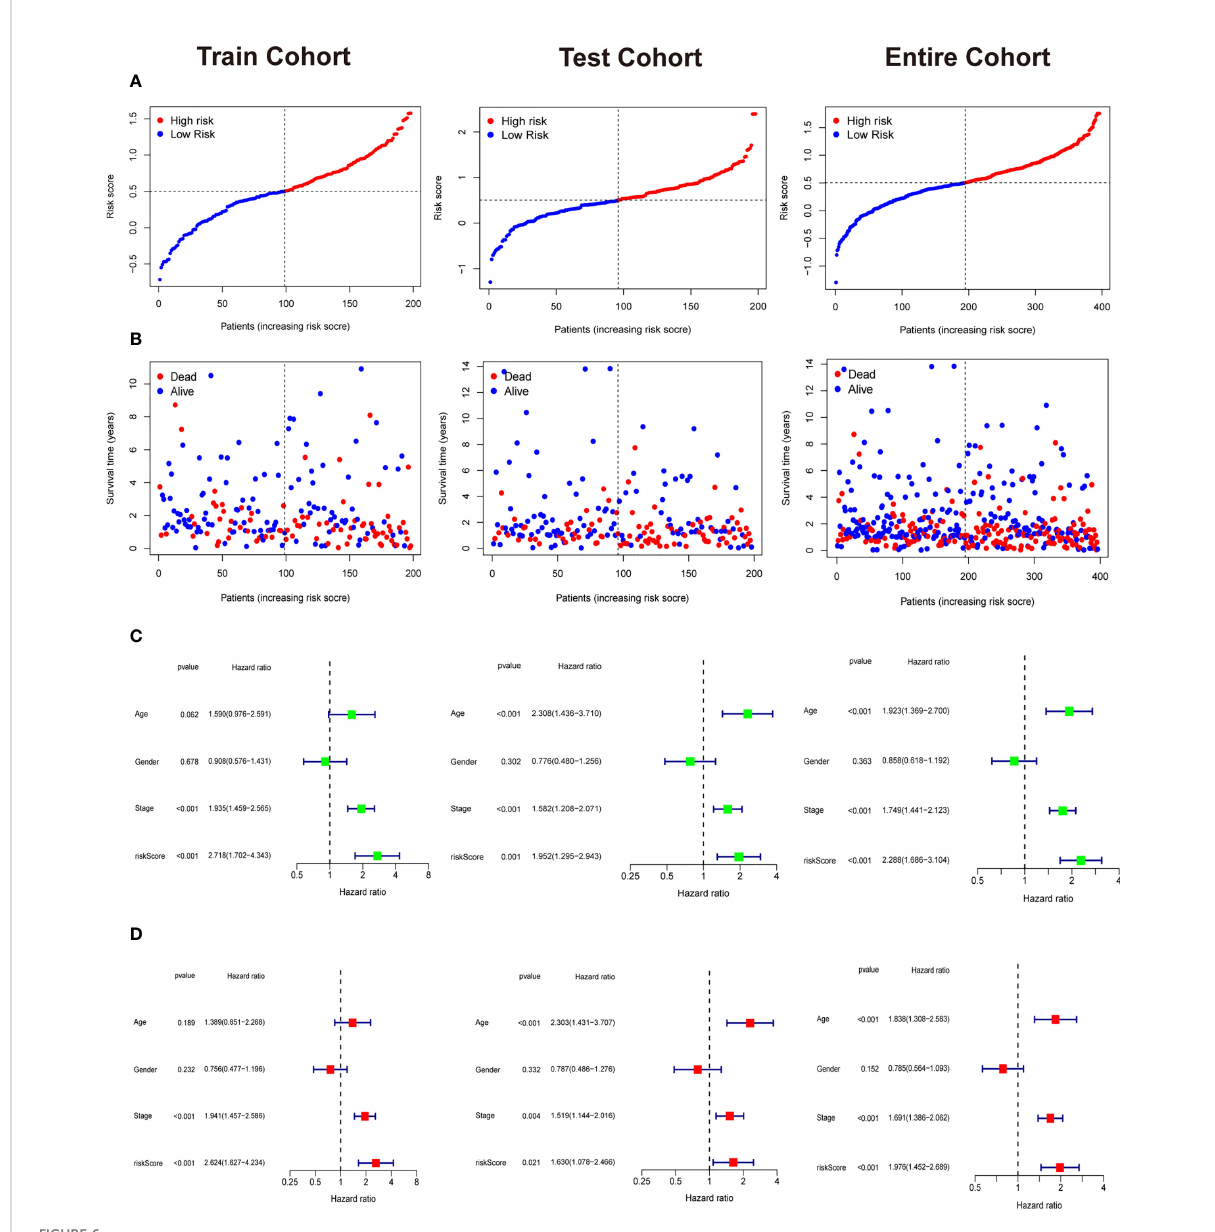
FIGURE 6 Independent prognostic analysis and the correlation between survival status and riskscore. (A) The riskscore curve in train cohort, test cohort, and entire cohort. (B) Patients ’ status as riskscore increases in train cohort, test cohort, and entire cohort. (C) Univariate Cox analysis in train cohort, test cohort, and entire cohort. (D) Multivariate Cox analysis in in train cohort, test cohort, and entire